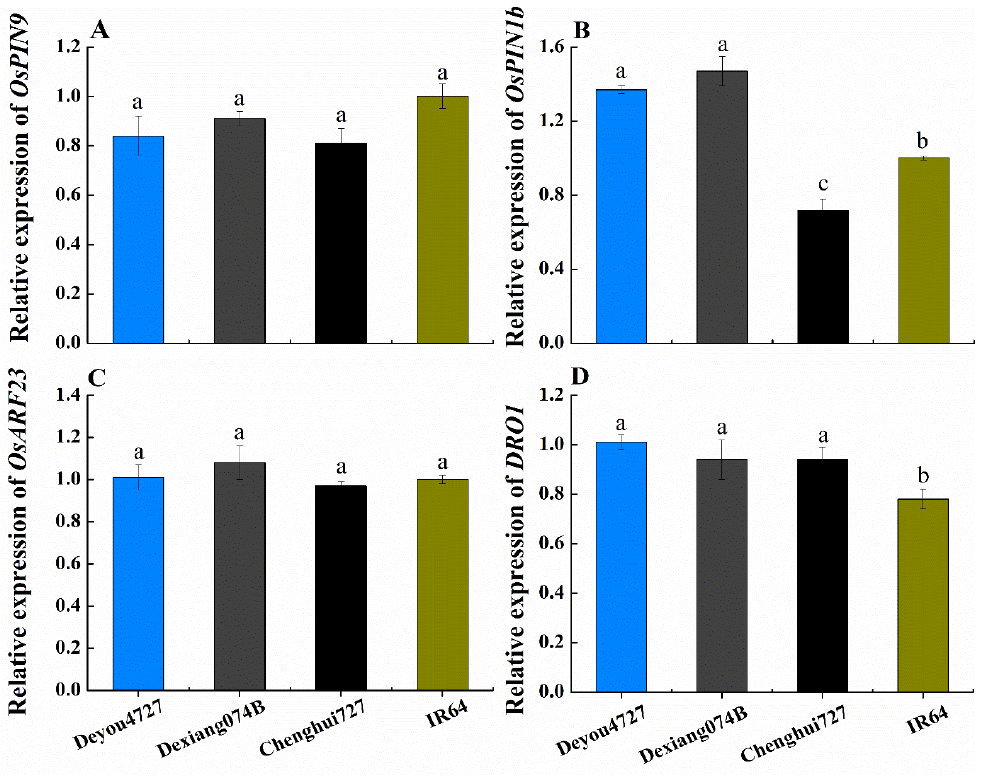
Figure 5. The expression of OsPIN9 ( A ) , OsPIN1b ( B ) , OsARF23 ( C ) , and DRO1 ( D ) in Deyou4727, Dexiang074B, Chenghui727, and IR64. The values in each graph represent the Mean ± SE (standard error) of three replicates, and lowercase letters indicate significant differences between varieties and treatments, at p < 0.05. Table 3. The DRO1 sequence of Deyou4727, its parents, and